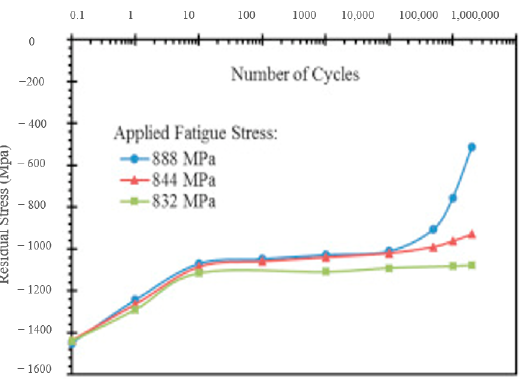
Figure 12. Residual stress relaxation of USNM’ed specimen treated with three fatigue stresses. Re- printed with permission from ref. [69]. Copyright 2018, Elsevier.